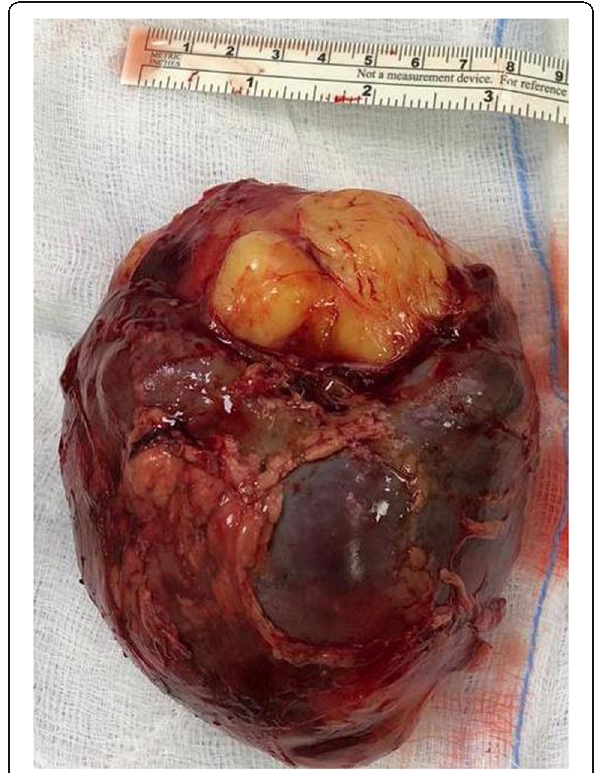
Fig. 3 Gross appearance of the excised tumor showing smooth surface intact capsule and heterogenous